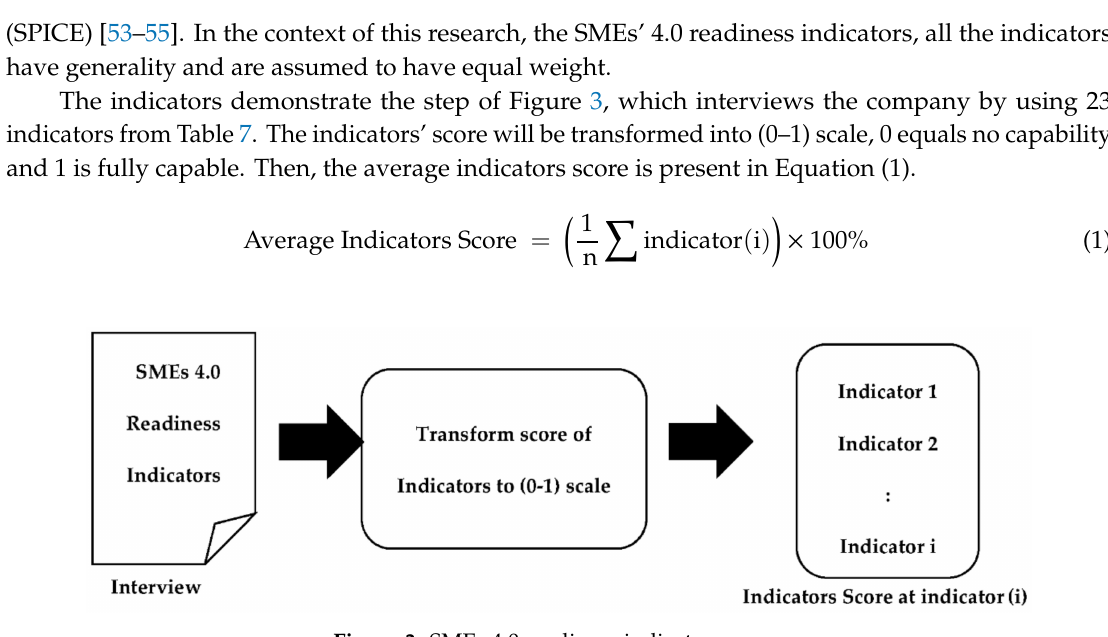
Figure 3. SMEs 4.0 readiness indicators